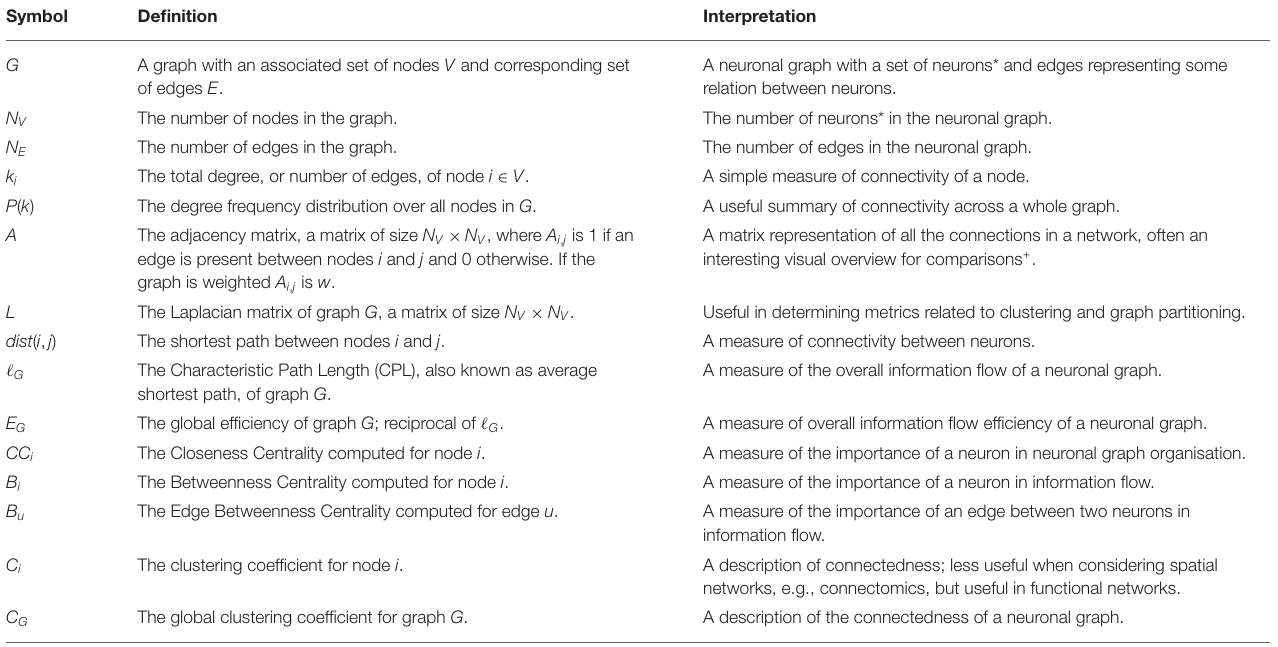
TABLE 1 | A list of symbols and definitions as used in this paper.